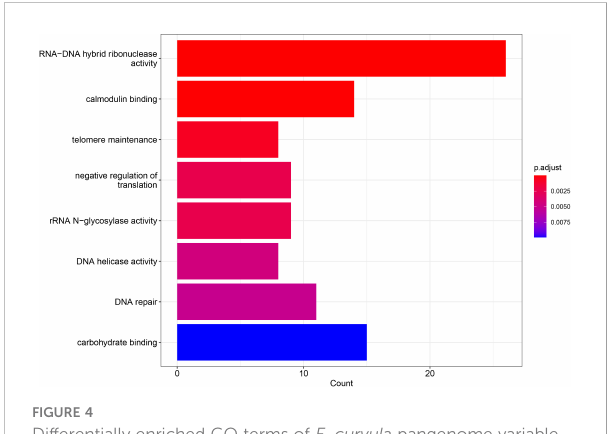
FIGURE 5 Phylogenetic tree of Eragrostis curvula including